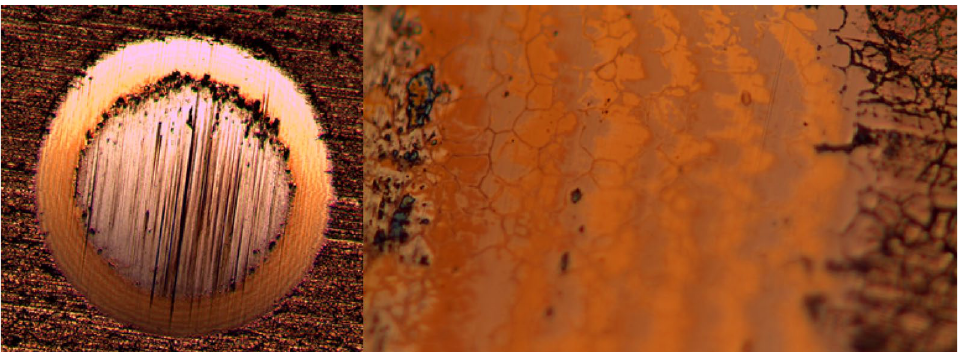
Figure 4. Calotest images for (left image) PN14 at ×5 and (right image) PN14 at